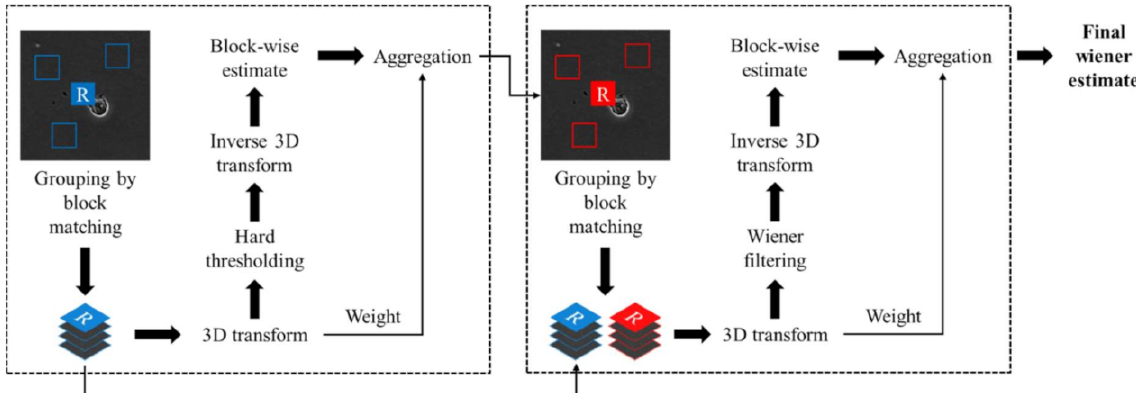
Figure 2. BM3D flowchart. Adapted from ref.